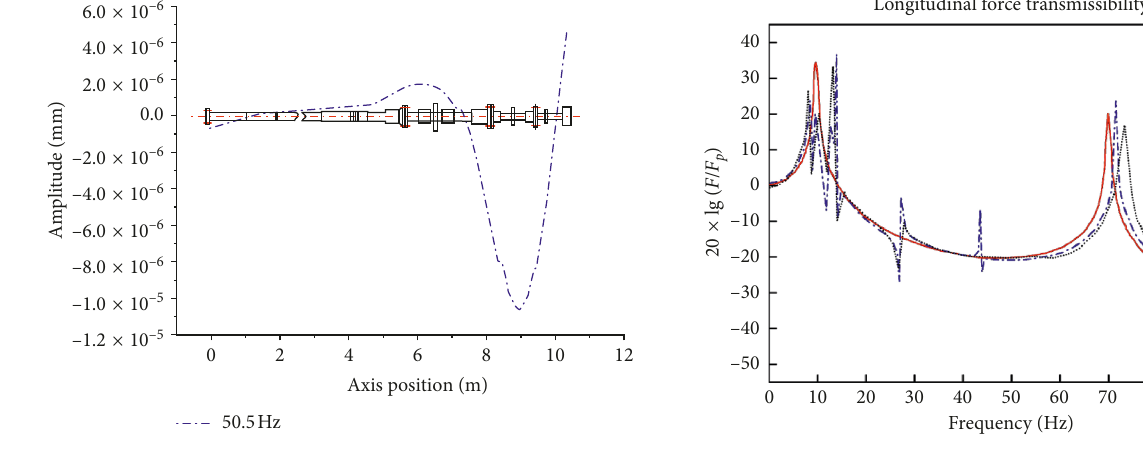
Figure 11: Local bending shape of shafting.